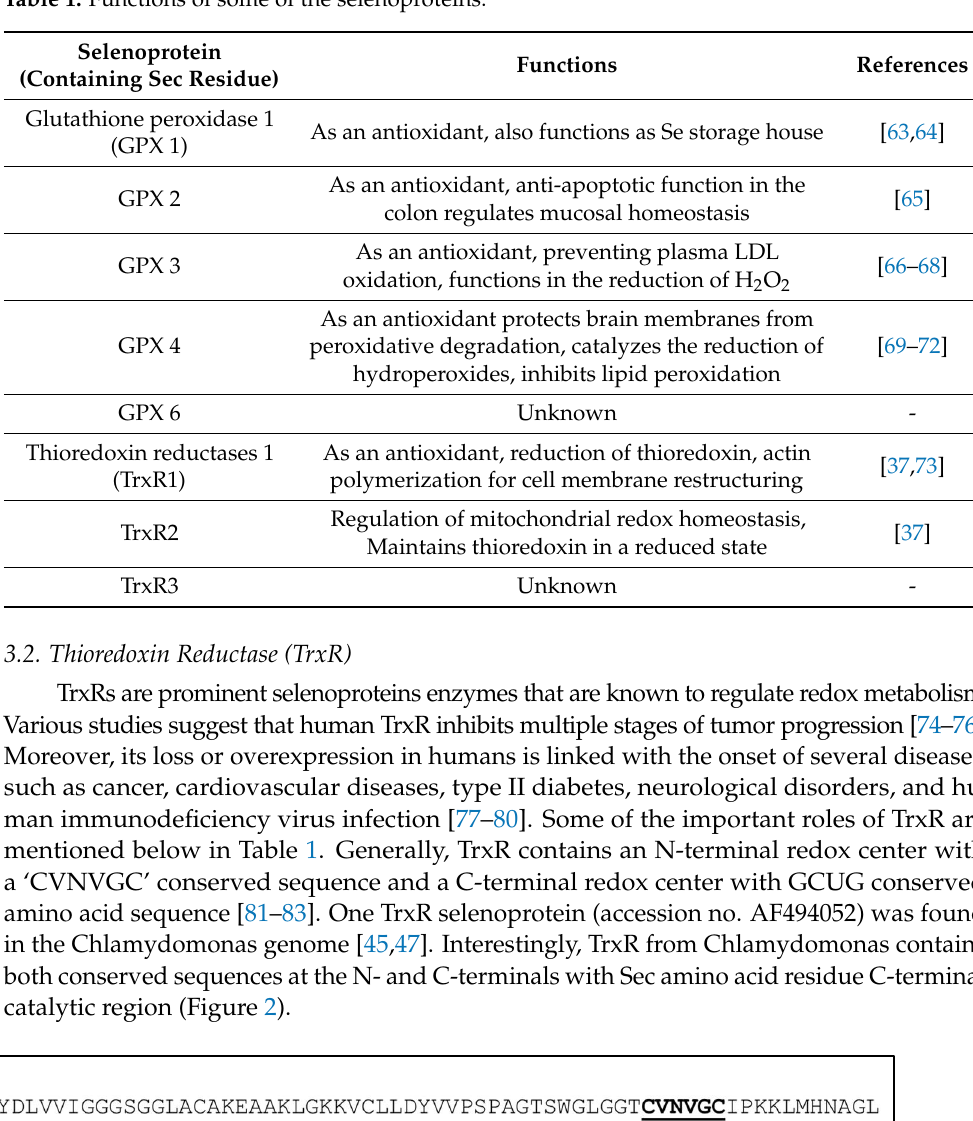
Figure 2. TrxR selenoprotein sequence from Chlamydomonas with conserved catalytic domains. Catalytic domain (CVNVGC and GCUG), underlined in bold; Sec, underlined bold red U; *—stop codon.